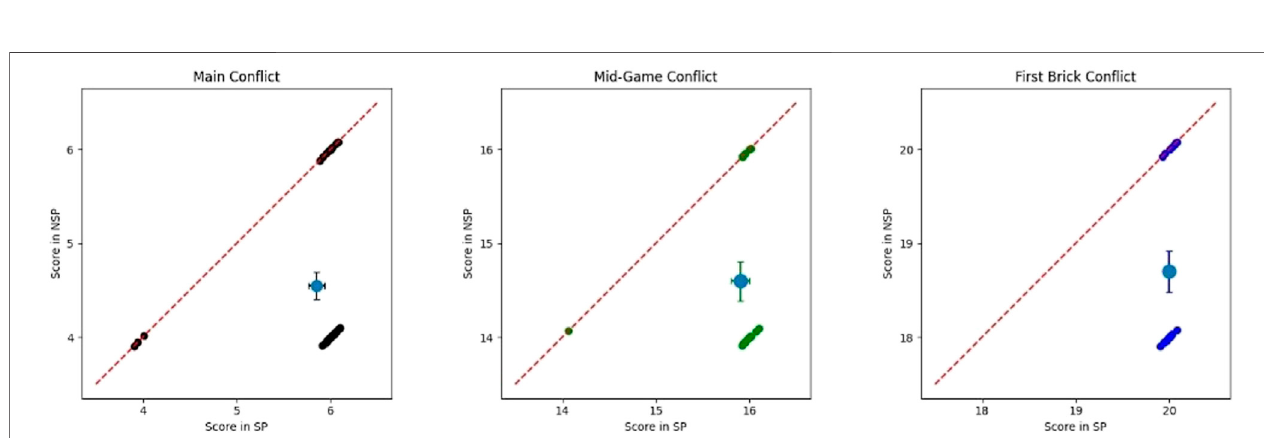
FIGURE4 | Participants ’ score inboth SPand NSP conditions during the con fl icts. (A) isreferred tothe MainCon fl ict, (B) tothe Mid-Game Con fl ict, and (C) tothe First Brick Con fl ict. We applied a Gaussian random noise ( μ = 0, σ = 0.05 on both the x and y axis) to make all of them visible. It is also shown the average score with standard